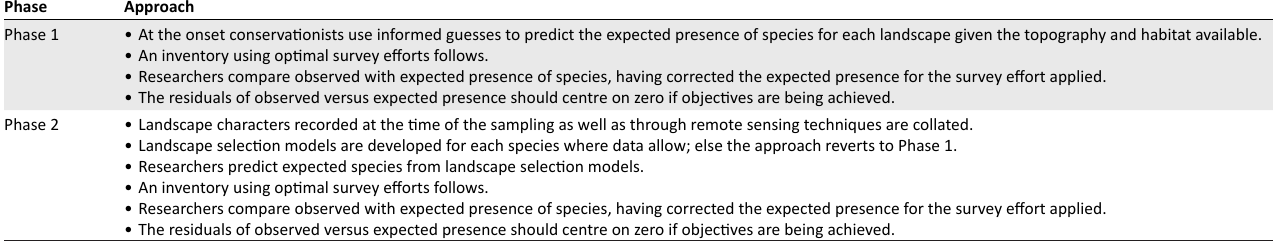
FIGURE 3: SANParks uses a linkage framework that connects objectives, drivers, mechanisms and modulators. Typically, conservationists seek nondirectional variance in biodiversity over time – a key objective. A hypothetical set of linkages relate ecosystem (biodiversity) objectives to key drivers and an indicator of such a driver. There are also linkages to the likely mechanism of how a driver affects biological diversity and factors that act as modulators on the mechanism. This example uses elephants and illustrates that management responses focus on modulators and that information requirements are diverse (Adapted from Gaylard, A. & Ferreira, S.M., 2011, ‘Modification and maturation of SANPark’s adaptive planning process – making critical linkages between conservation objectives and actions’, Koedoe 53(2), Art. #1005, 8 pages. doi:10.4102/koedoe.v53i2.1005). TABLE 3: Example of a predictive inventory approach for rare species and species of special concern inhabiting nondegraded